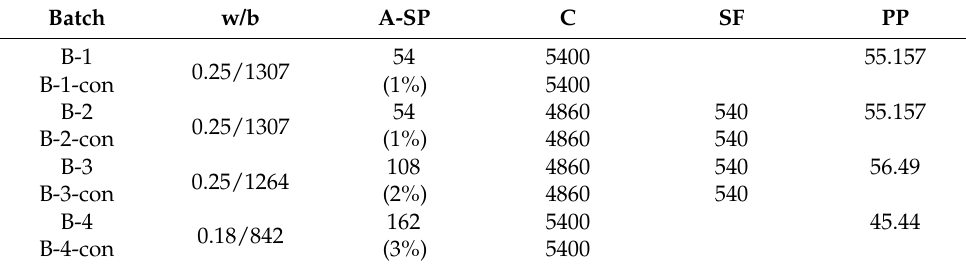
Table 2. Mix proportion for mechanical properties of fiber-binder